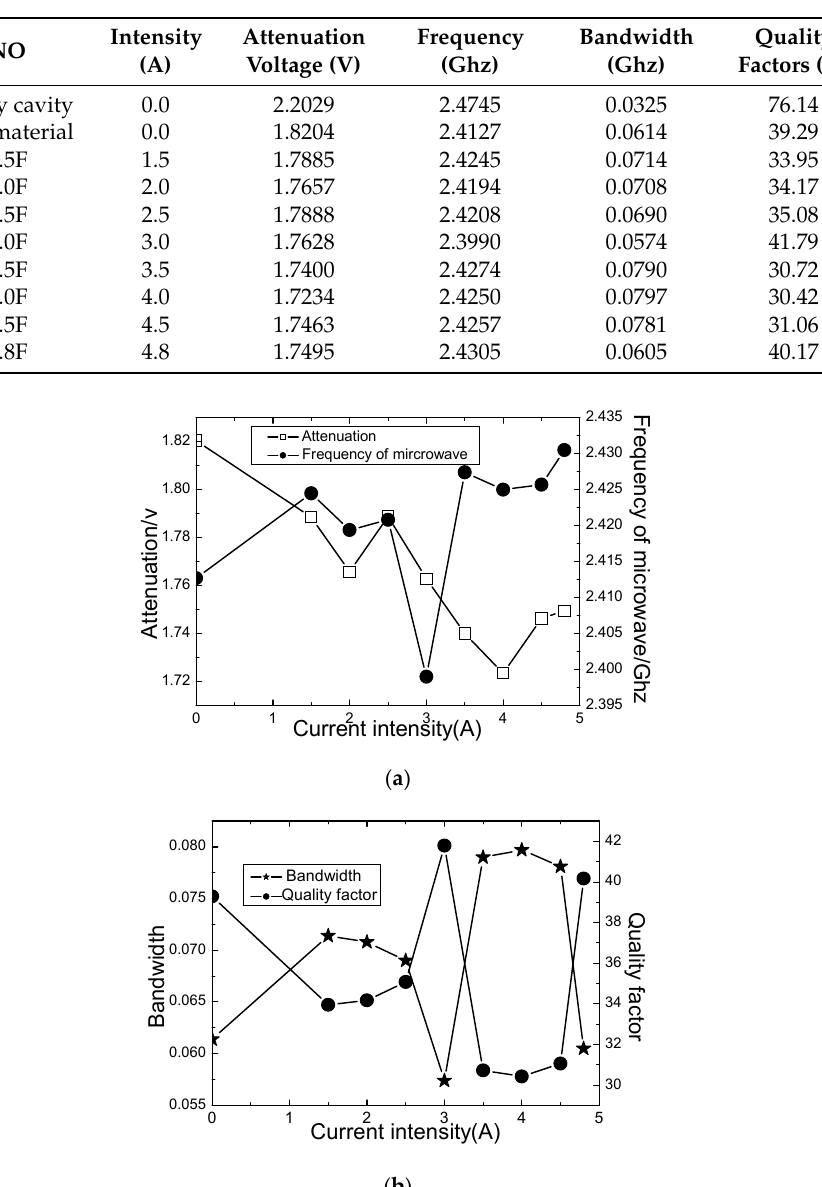
Table 4. Measured parameters of microwave-absorbing characteristics for the non-magnetic products.